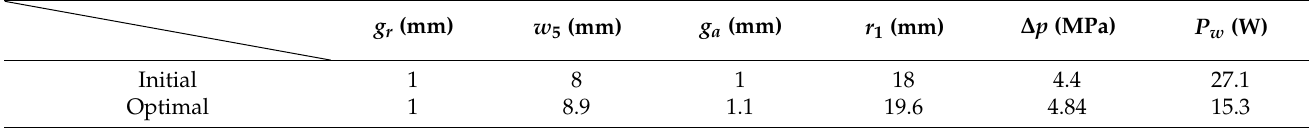
( b ) Figure 14. Prototype of the initial and optimal MR valve: ( a ) valve parts, ( b ) valve assembly. 1. Left end cover, 2. Valve body, 3. Left positioning plate, 4. Magnetic ring, 5. Right end cover, 6. Damping disk, 7. Nonmagnetic disk, 8. Right positioning plate, 9. Nonmagnetic ring.